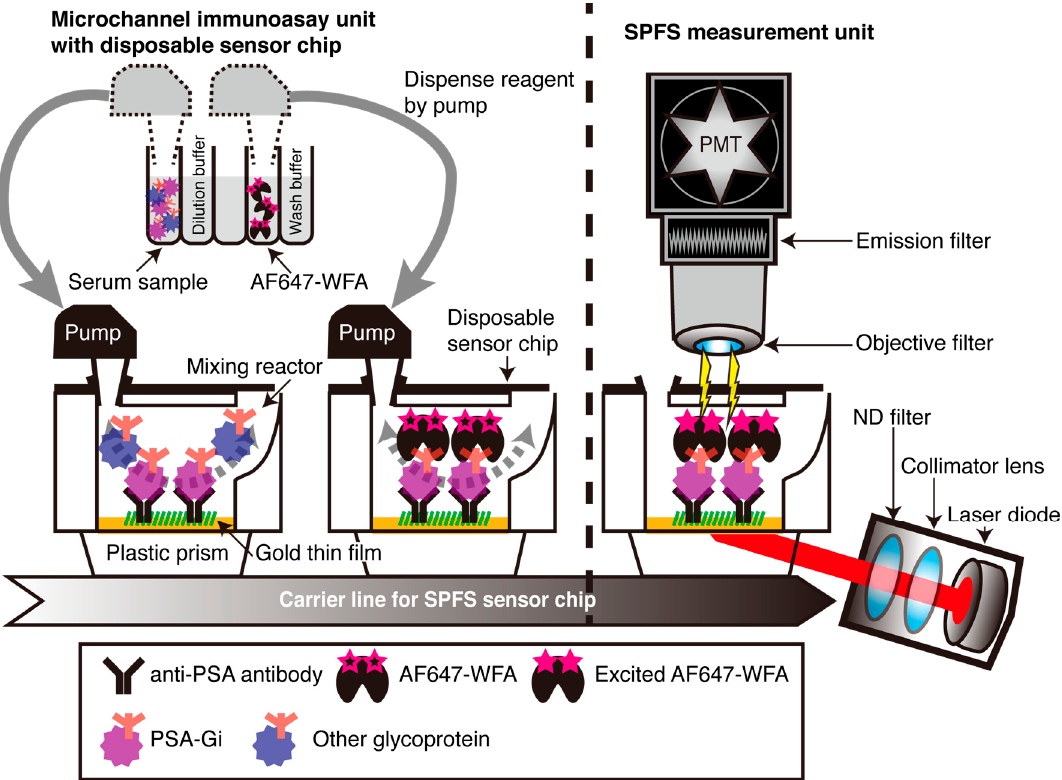
Figure 2. The schematic representation of serum PSA-Gi detection using a two-step surface plasmon field-enhanced fluorescence spectrometry (SPFS)-based WFA lectin-anti-PSA antibody immunoassay. Gray line arrows indicated that reagent dispense from reagent container to mixing reactor using pump. Gray dotted line arrows indicated mixing the content of mixing reactor by pump.